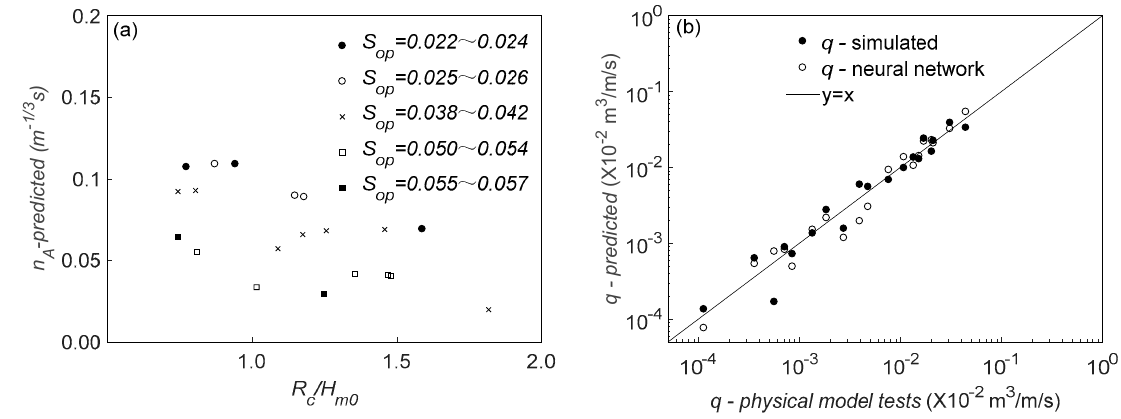
Figure 8. The predicted n A values ( a ) and the comparisons of q from the physical model tests (CLASH project) with the q simulated by the SWASH model based on the estimated n A (Equation (7)) and the q